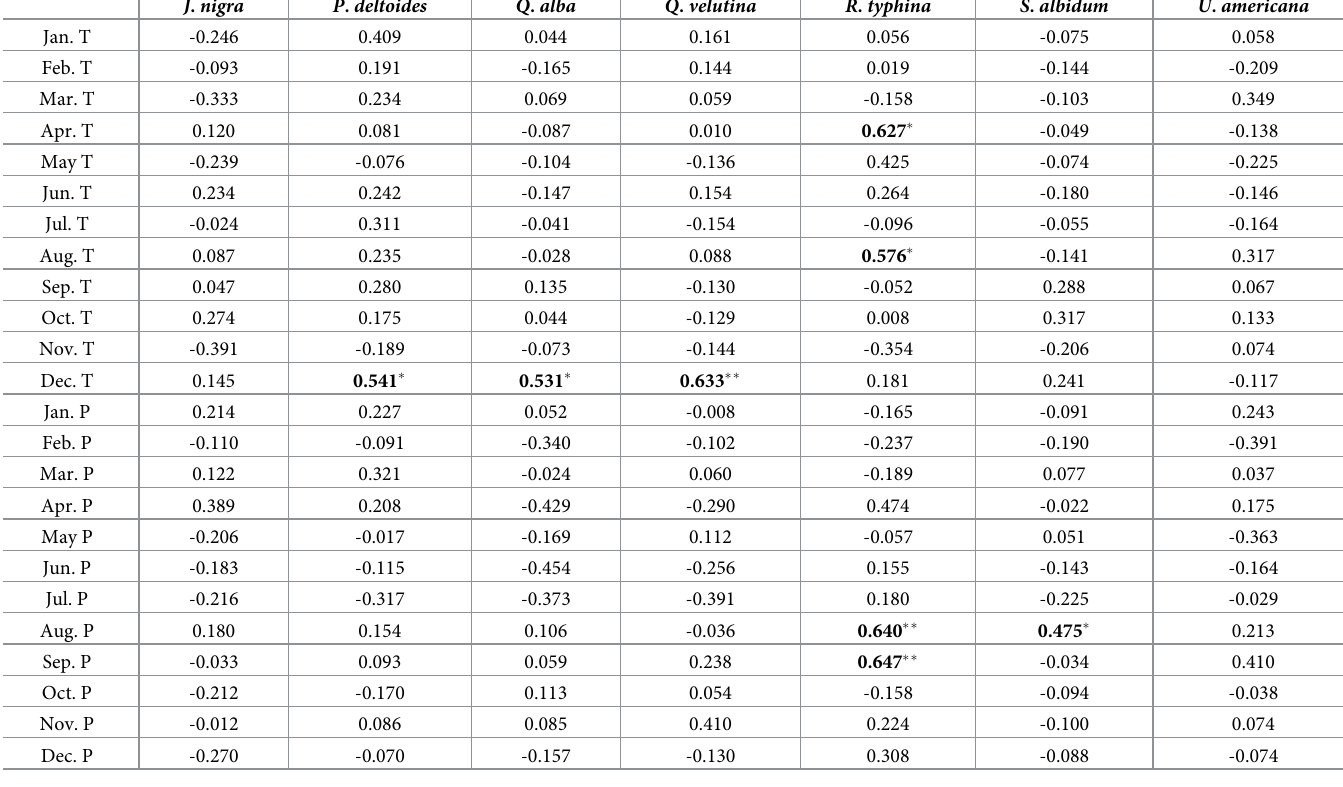
Table 2. Correlation coefficients for foliage coloration DOY with mean monthly temperature (˚C) and total monthly precipitation (cm) for the month of and 11 months preceding budburst in the seven focal